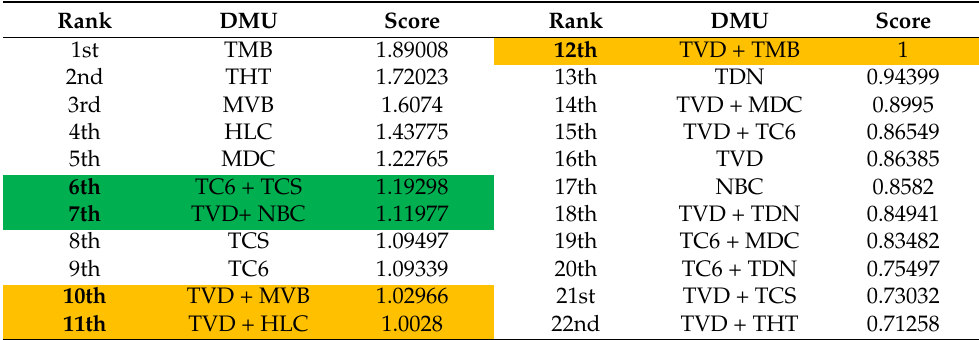
Table 10. Performance ranking of virtual alliance 2022.